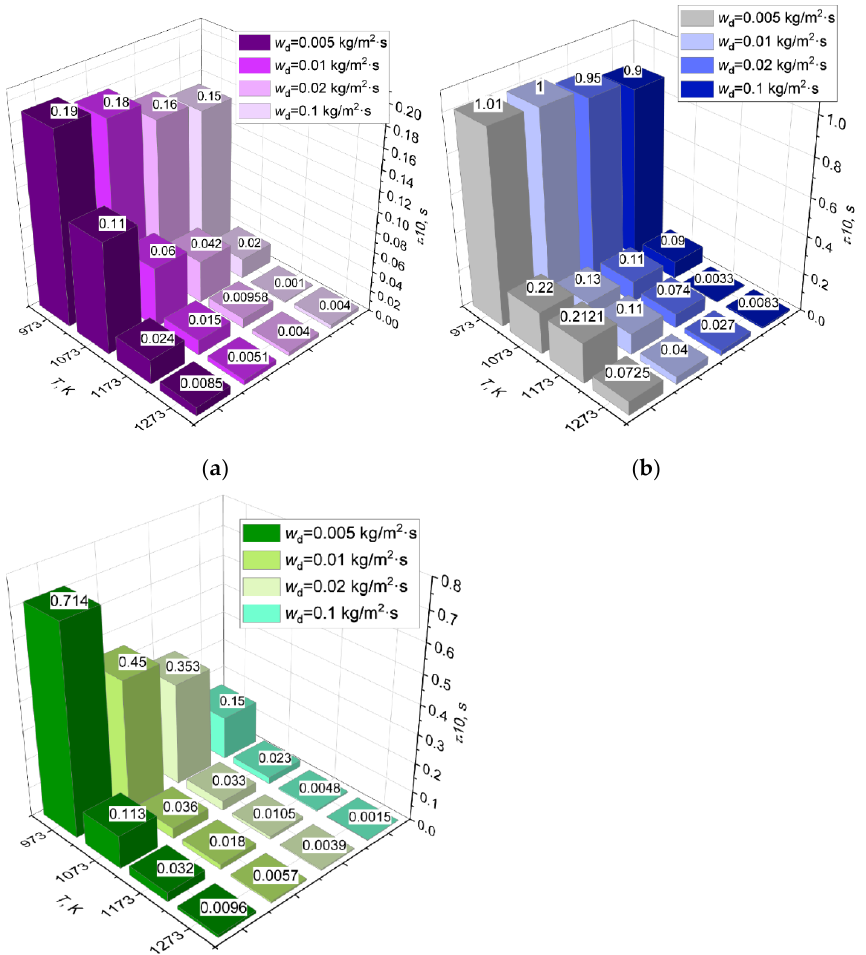
Figure 5. The ignition delay times of the gas hydrate ( R g = 0.5 m) when varying the dissociation rate and temperature for the three heat exchange schemes: ( a ) radiant, ( b ) convective, ( с ) conductive. Figure 6a–c presents the temperature fields in the gas hydrate ignition area when using convective heating and varying the mass dissociation rate for a heating source temperature of 1273 K. Significantly, the temperature traces were distributed identically around the gas hydrate particle with R g = 0.5 mm, irrespective of the dissociation rate.